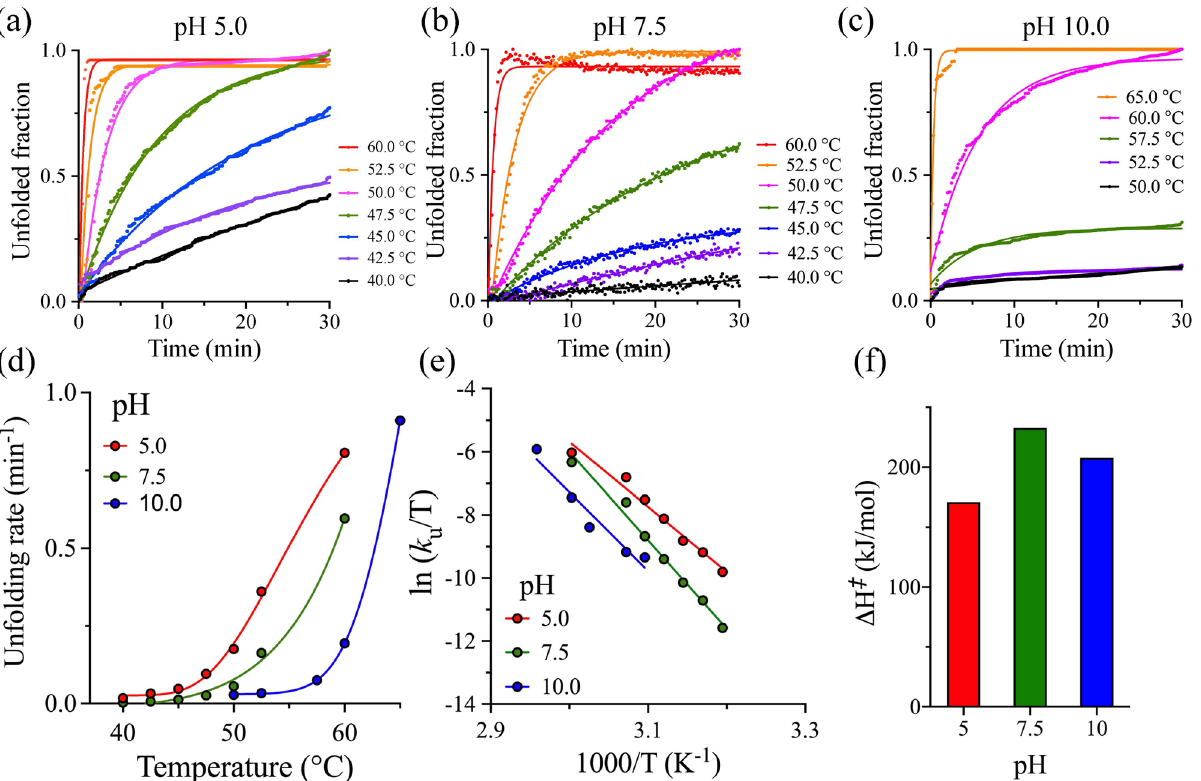
Figure 5. The thermal kinetic stability of 3CLpro. ( a–c ) Time courses of thermal denaturation of 3CLpro at different temperatures from 40.0 to 65.0 °C at different pH values of 5.0, 7.5, and 10.0. The change in ellipticity was continuously monitored at 222 nm for 30 min. Points on the graphs represent experimental data, and lines are the theoretical fit of the data to a single exponential function. The rate of unfolding ( k U ) was calculated from the linear portion of the graphs. ( d ) k U plotted as a function of temperature at different pH values. The 3CLpro shows the highest unfolding kinetics at pH 5.0. On the other hand, pH 10.0 displayed the highest kinetic stability with a slow rate of unfolding with incubation temperature lower than 57.5 °C. ( e ) Eyring plot of the temperature dependence of k U for 3CLpro at different pH values. Points on the graph are experimental data, and lines are the linear least-square regressions to experimental data. Changes in the slope of the lines are observed as a result of variation in Δ H ‡ . ( f ) Bar plot of Δ H ‡ of the temperature dependence of the unfolding rate constant at different pH values with the highest Δ H ‡ observed at pH